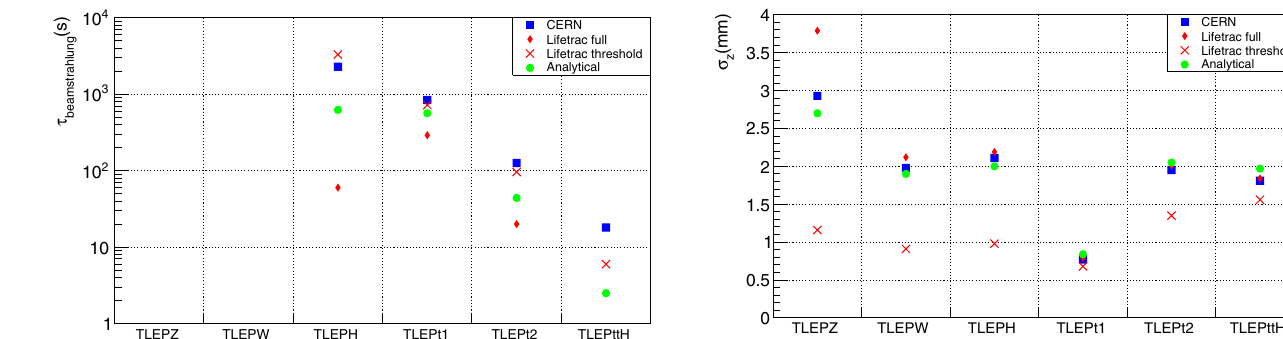
FIG. 2. Beam lifetime for different scenarios of TLEP oper- ation. Blue squares are taken from Table I, red diamonds are L IFETRAC results with full spectrum of beamstrahlung, red crosses are L IFETRAC results if beamstrahlung is considered for emission of photons with energy higher than acceptance, and green dots are our analytical calculations. Lifetimes for TLEPZ and TLEPW are so large, therefore not plotted.